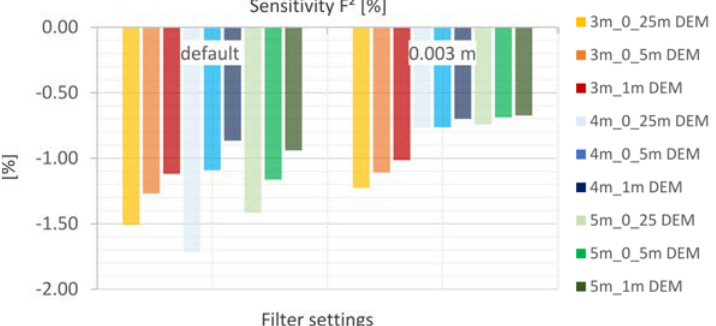
Figure 34. Comparison of the model sensitivity (S-F 2 ) for the filter settings and the evaluated mesh and DEM resolutions.